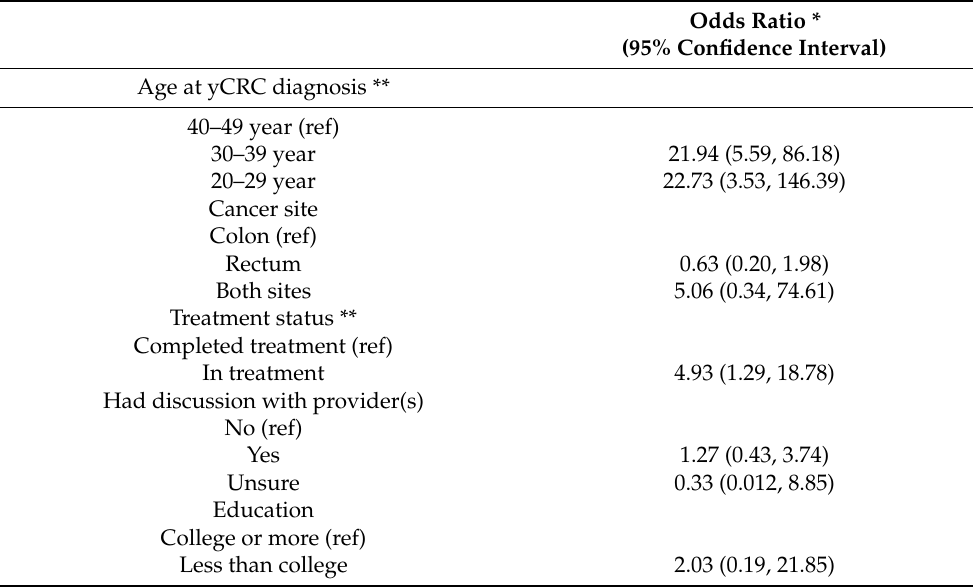
Table 3. Multiple logistic regression model showing factors associated with having family planning influenced by yCRC